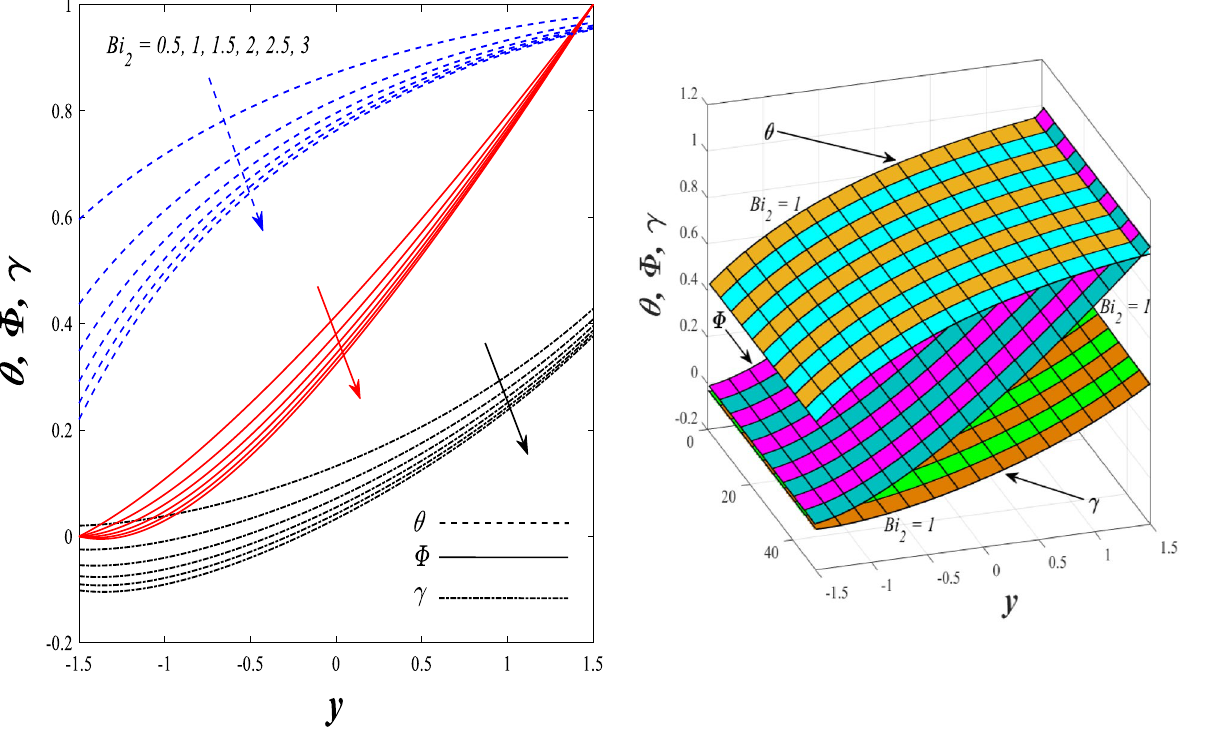
Figure 21. Effect of heat Biot number Bi 2 on the distributions of both temperature, solutal concentration, and nanoparticles volume fraction.